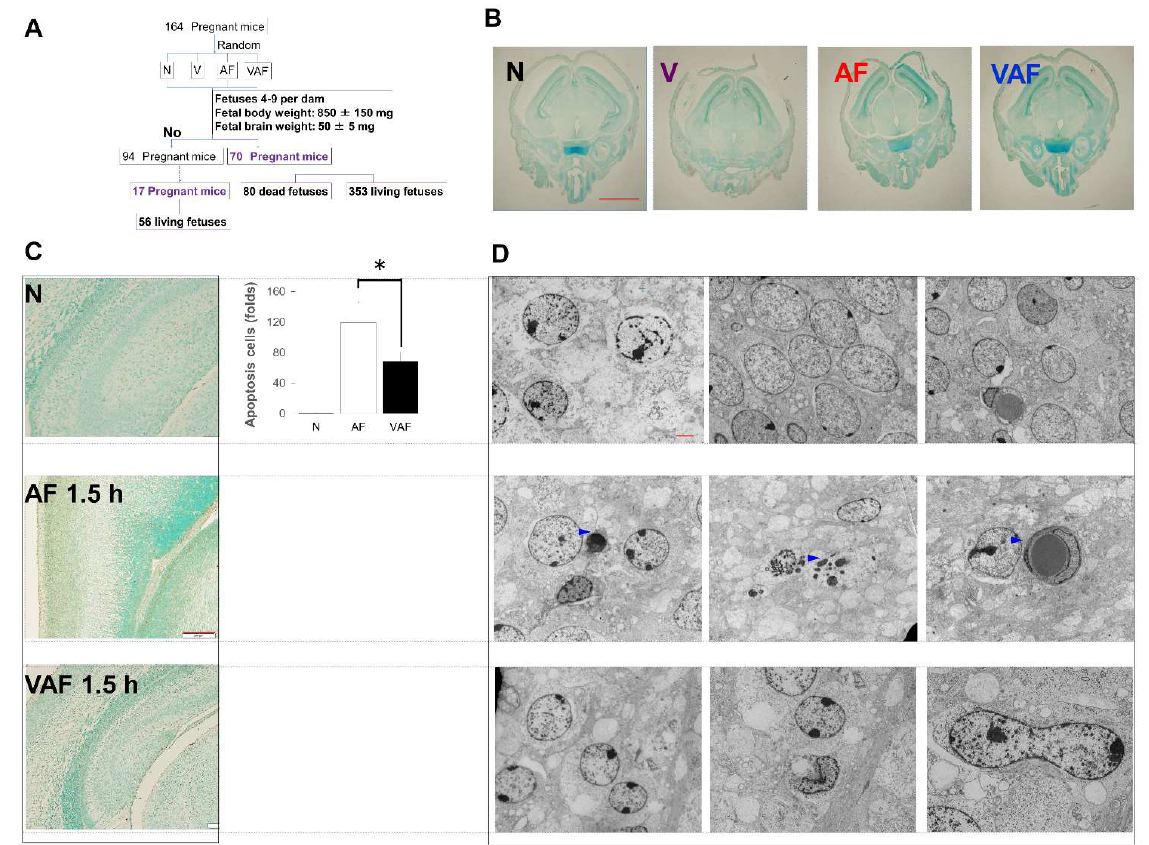
Figure 3. Time-course investigation of cell death in the fetal brain. ( A ) Quantitative and qualita- tive analyzes of fetal mouse brains, details in materials and methods. ( B ) No detectable cell death in the whole fetal brains of N, V, AF 0.5 h and VAF 0.5 h (×1.25 microscopy). Scale bar means 2 mm. ( C ) 1.5 h of AF and VAF cell death measure (brown doses are positive apoptosis cells). Scale bar means 200 μm. * p < 0.05. ( D )Transmission electron microscopy images of cell death in the Native, Apoptosis [blue triangles in AF (1.5 h), Scale bar means 2 μm